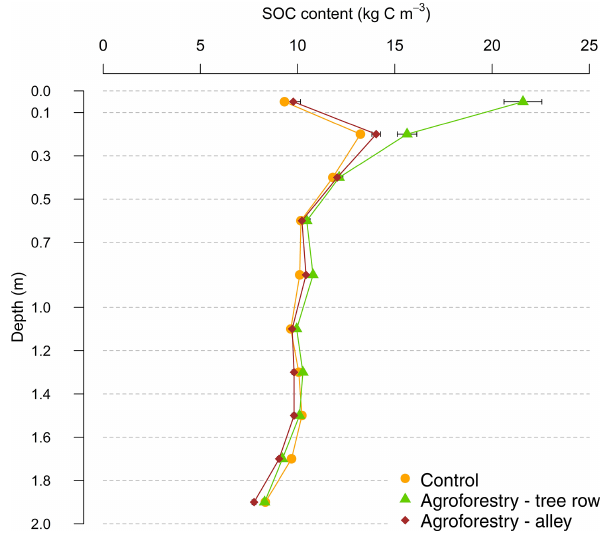
Figure 1. Soil organic carbon content in both the agroforestry and agricultural control plot. Associated errors are standard errors. N = 93 in the control, N = 40 in the agroforestry tree row, N = 60 in the agroforestry alley. Data from Cardinael et al.